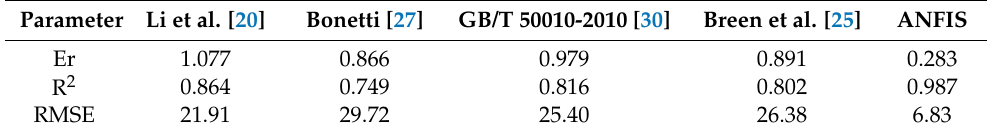
Figure 13. Final results of the proposed formulation based on ANFIS: ( a ) Regression plot for the experimental results vs. ANFIS; ( b ) Error-values obtained from the model. Table 6. The comparison results.